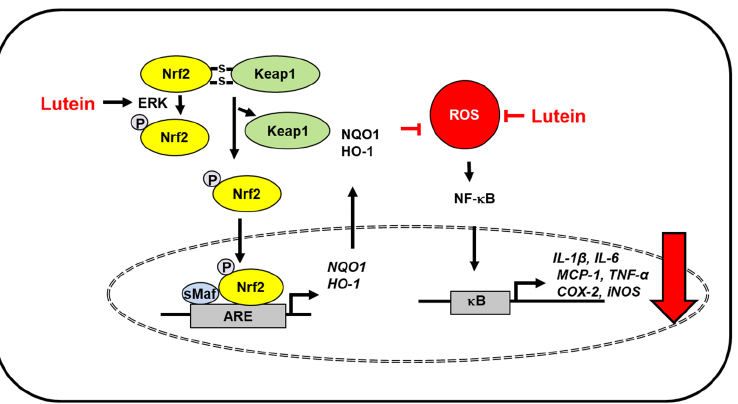
Figure 1. The proposed mechanism by which lutein inhibits oxidative stress-induced inflammatory responses in the brain. ROS levels increase in severe traumatic brain injury and lipopolysaccharide- activated microglia. Lutein reduces ROS levels and inhibits ROS-mediated activation of NF-kB and expression of inflammatory mediators (IL-1 β , IL-6, MCP-1, TNF- α , COX-2, iNOS) [37]. In lipopoly- saccharide-activated microglia, lutein activates ERK, which phosphorylates Nrf2 and increases dis- sociation of Keap1 from the Nfr2/Keap1 complex. Thus, it promotes nuclear translocation of Nrf2, which forms a heterodimer with sMaf protein and binds to a regulatory region of DNA called ARE. It induces the expression of Nrf2- target antioxidant genes (HO-1, NQO1). These antioxidant en- zymes reduce intracellular ROS levels, which suppresses inflammatory responses [38]. Thus, lutein prevents oxidative stress-mediated neuroinflammation. A RE, antioxidant response element; COX- 2, cyclooxygenase-2; ERK, extracellular signal-regulated kinase; HO-1, hemeoxygenase-1; iNOS, in- ducible nitric oxide synthase; IL, interleukin; Keap1, kelch like ECH associated protein 1; MCP-1; monocyte chemoattratant protein-1; NF −κ B, nuclear factor- κ B; Nrf2, nuclear factor erythroid 2–re- lated factor 2; NQO-1, NAD(P)H: quinone oxidoreductase 1; ROS, reactive oxygen species; sMaf, small Maf; TNF- α , tumor necrosis factor- α . 2.2. Eye Diseases Lutein, as a component of macular pigment, protects the macula from photo-oxida- tive damage and enhances visual function [29]. Lutein is an ocular antioxidant that can quench both singlet oxygen and lipid peroxy radicals [43]. In addition, lutein inhibits ac- tivation of STAT3 and IL-6 expression in the retina [7]. Therefore, supplementation with lutein has been very effective for restoring ocular antioxidants of age-related maculopathy and AMD [44–46] Oxidative stress is an important factor in the pathogenesis of age-related macular degeneration; thus, anti-oxidative stress is a good marker for the prevention or treatment of age-related macular degeneration. Lutein is a very effective quencher of singlet molec- ular oxygen and lipid peroxy radicals. However, lutein gets oxidized to its corresponding radical cations in the process. These cations must be reduced to regenerate the original carotenoids, which thus, allows its use as an antioxidant [47]. Lutein reduced ROS levels and suppressed apoptosis by reversing G2/M phase arrest through activation of cyclin- dependent kinase 1 and cell division cycle 25C in retinal pigment epithelial cells exposed to hydrogen peroxide [48]. Bian et al. [49] showed that lutein suppressed lipopolysaccha- ride-stimulated production of IL-6 and TNF- α in both retinal pigmental epithelial cells